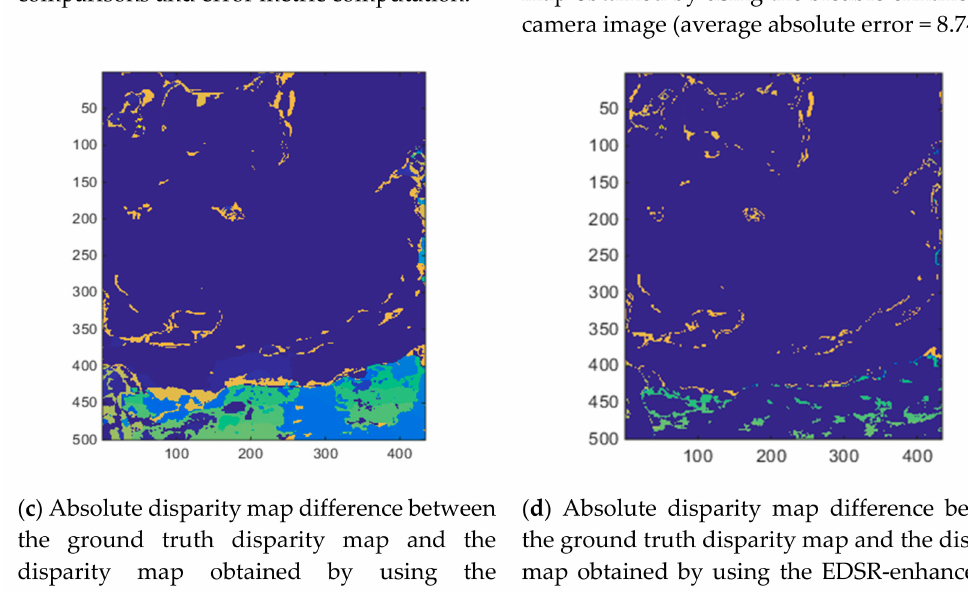
Figure 9. Absolute disparity map di ff erences between the ground truth disparity map and the disparity maps obtained with the three methods and the corresponding left camera image for the overlapping disparity map